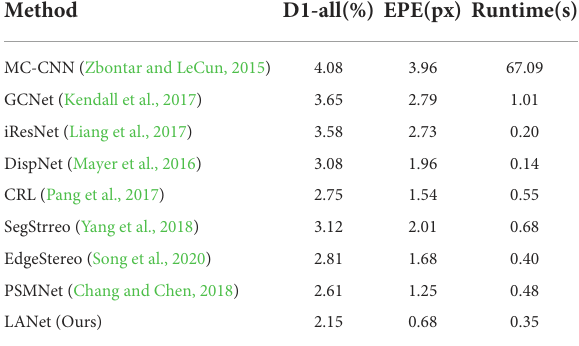
EPE reduction from 0.82 to 0.68. LANet was tested on a 3090 GPU and Forest dense test set, with an image resolution of 1240*426. The runtime was closely related to the performance of the experimental device and the size and density of the image, under our experimental conditions, the D1-all, EPE and runtime of PSMNet are 2.61, 1.25 and 0.48, respectively, while those of LANet are 2.15, 0.68 and 0.35, respectively, which are better than the baseline model PSMNet. In terms of Runtime, iResNet is 0.2 and DispNet is 0.14, which is better than our 0.35, but their accuracy is very low, which D1-all is 3.58 and 3.08, respectively, while ours is 2.15. Figure 7 shows the visualization of disparity maps generated by LANet, PSMNet, and GCNet on Forest, with color representing the different disparity values and black indicating points where the disparity values are very small and can be ignored at longer distances. The yellow and green rectangular are areas of poor model matching, usually found in locations containing delicate and intricate structures such as branches, tree trunks, leaf edges, and weakly textured areas such as the rear glass of a car and obscured locations. In column A, the pink part of the yellow rectangular area shows the trees in the distance and the dark red part show the sky, with significant differences in predictions between models at the borders of the trees and the sky. PSMNet and GCNet can keep the main outline of the edge, but the matching of the delicate and intricate structure is not accurate enough, while LANet can keep the delicate and intricate features of the edge better and the prediction is closer to the true value. In column B, the yellow rectangular area is the distant tree trunk and the rear glass of the car. For the prediction of the red trunk, PSMNet and GCNet appear pixel missing, while the prediction of LANet is more accurate. For the pink rear glass of the car, LANet has a slight depth color deviation, while PSMNet has more depth color deviation and GCNet has more depth color error. In column C, the green rectangular area is the trunks and leaves in the distance. With LANet showing pixel discontinuities and a little missing for the red trunks, PSMNet and